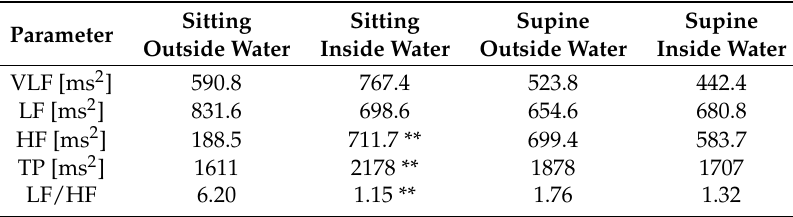
Table 2. Frequency domain HRV parameters as a mean over all subjects. Sitting Sitting Parameter Outside Water Inside Water